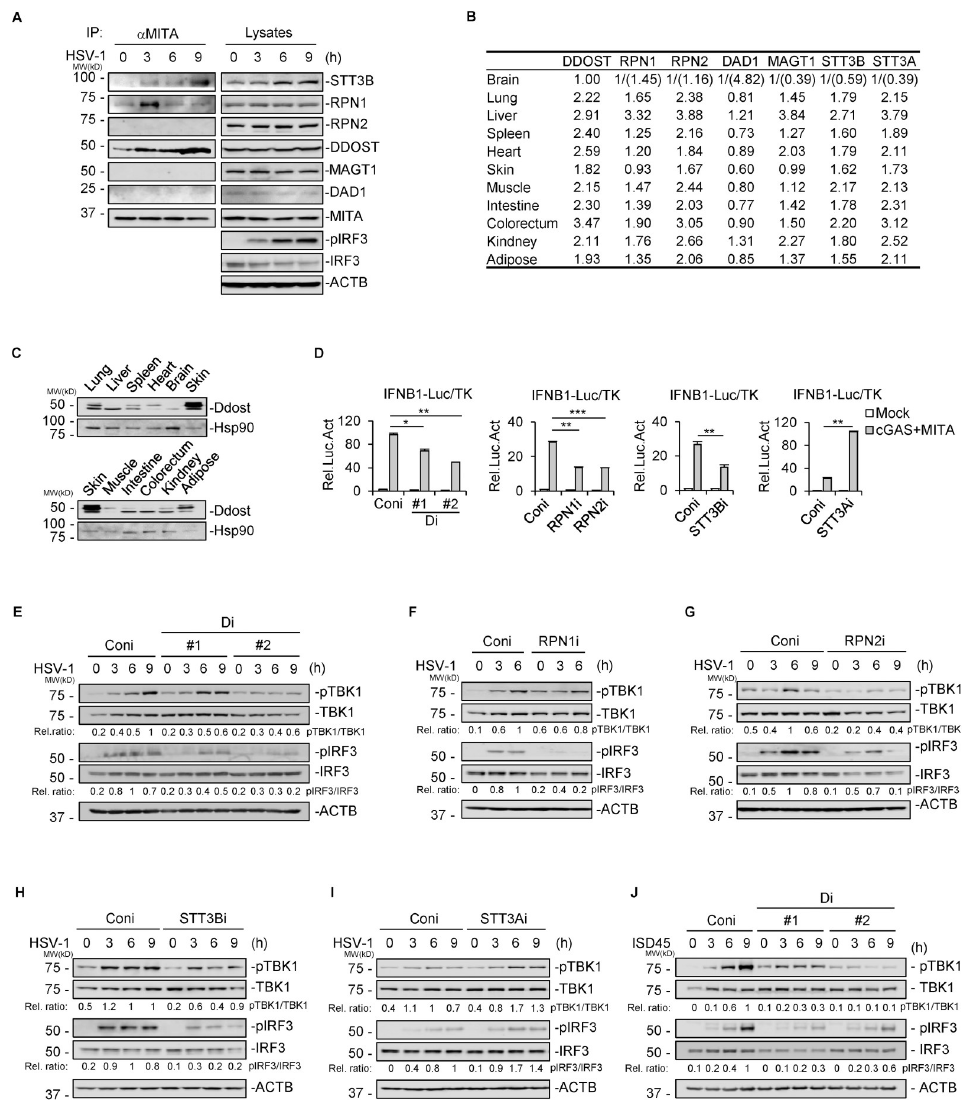
Fig 1. The OST complex is indispensable for antiviral IFN production. (A) THP-1 cells were infected with HSV-1 (MOI = 2) for the indicated time, and endogenous MITA was then immunoprecipitated with the indicated antibodies before immunoblotting analysis. ACTB: β -actin. (B) Consensus transcript levels of the indicated genes in human tissues were adopted from The Human Protein Atlas version 21.0 (www.proteinatlas.org) and are shown as the relative value to the transcript level of each gene in the brain. The values in the brackets represent the relative value to the transcript level of DDOST in the brain. (C) Different mouse organs were obtained and analyzed for the expression of Ddost by immunoblots. We discriminated proteins from humans or other species by a certain naming rule, for example, DDOST, as all letters capitalized to describe human proteins, and Ddost, as the first letter capitalized to describe mouse proteins. (D) HEK293T cells in 24-well plates were transfected with DDOST-RNAi NO.1 (Di#1), NO.2 (Di#2), RPN1-RNAi, RPN2-RNAi, STT3B-RNAi, STT3A-RNAi or empty vector control (Coni) by calcium phosphate transfection for 24 hours and then retransfected with pRK-HA-cGAS and pRK-HA-MITA together with the IFN β firefly luciferase reporter gene (50 ng/well) and TK Renilla luciferase reporter gene (5 ng/well) by Lipofectamine 2000. A dual luciferase reporter assay was performed after 24 hours. Data displayed are the mean ± SD of each technical repeat (n = 3), � P < 0.05, �� P < 0.01, ��� P < 0.001 (unpaired t test). (E-I) Stable DDOST-, RPN1-, RPN2-, STT3A- or STT3B-knockdown THP-1 cells were constructed and infected with HSV-1 (MOI = 2) for the indicated time before immunoblotting analysis. The relative ratio (Rel. ratio) of phosphorylated TBK1 (pTBK1) to TBK1 or phosphorylated IRF3 (pIRF3) to IRF3 was calculated by measuring the grayscale values of the bands and then normalized by the value at the time of the activation peak in the control group. One representative result from at least three independent experiments is shown. (J) DDOST knockdown THP-1 cells and control cells were transfected with ISD45 (2 μ g/mL) by Lipofectamine 2000 for the indicated time before immunoblotting analysis. The relative ratio (Rel. ratio) of pTBK1 to TBK1 or pIRF3 to IRF3